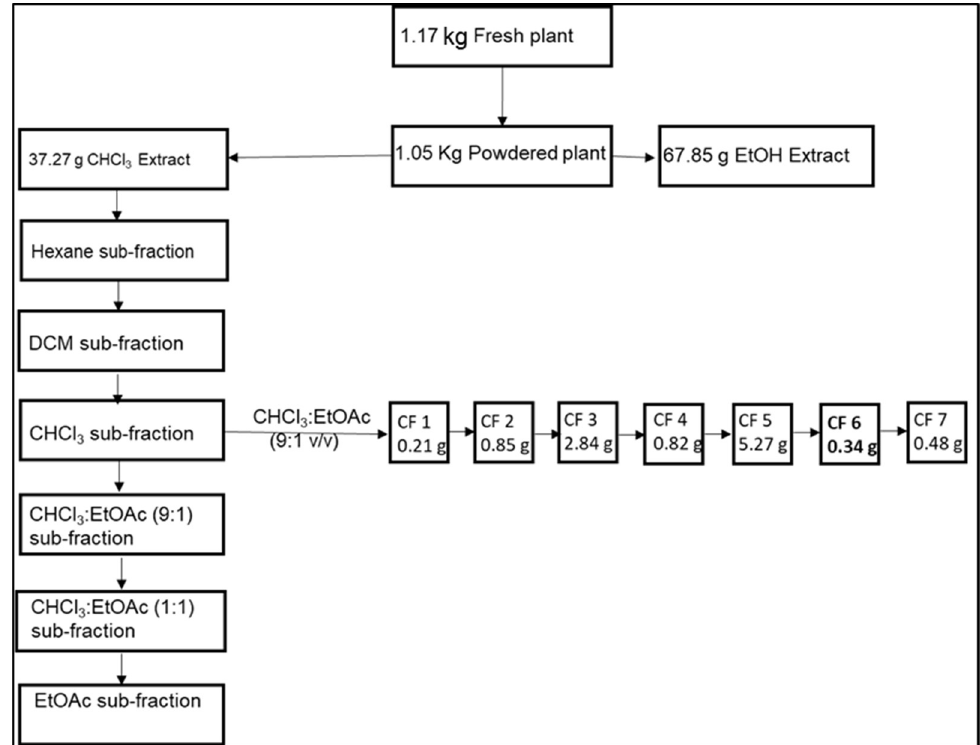
Figure 1. The summary of the isolated compounds is displayed.